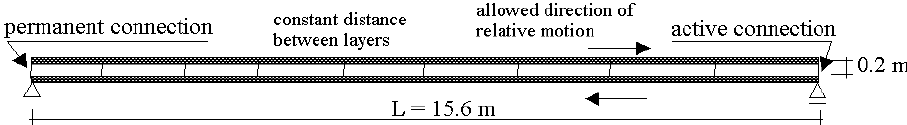
Fig. 9. Assumed model of layered beam.